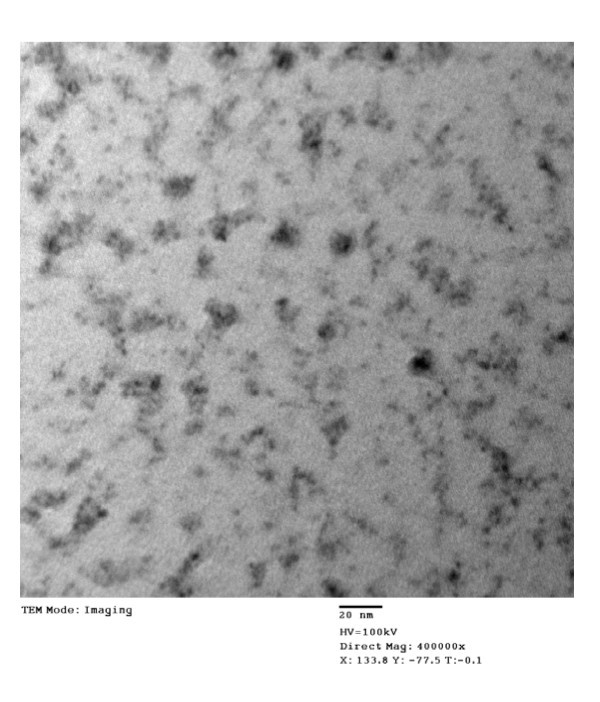
TEM image of Zn1-xMnxS nanocrystals.